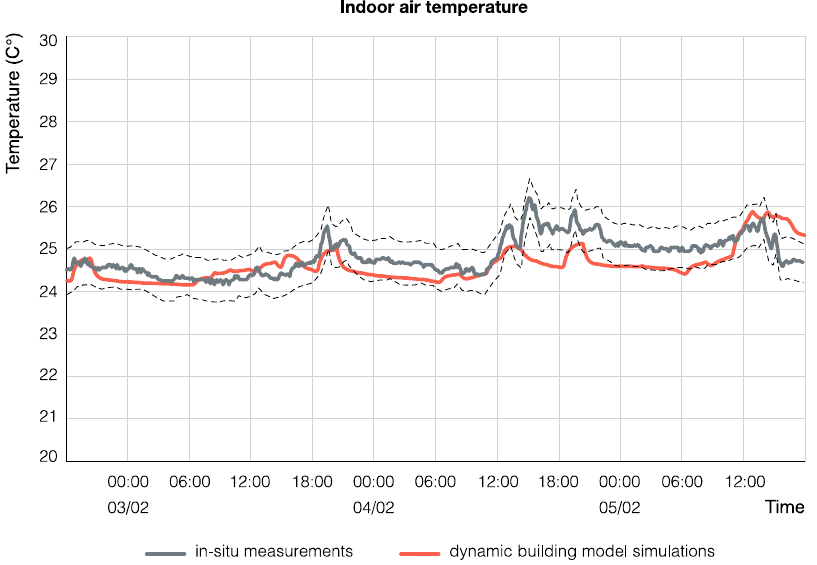
Figure 4. Simulated and monitored indoor air temperatures from 2 to 5 February 2017. The dashed curves represent the band ±0.5 °C of the measured values.